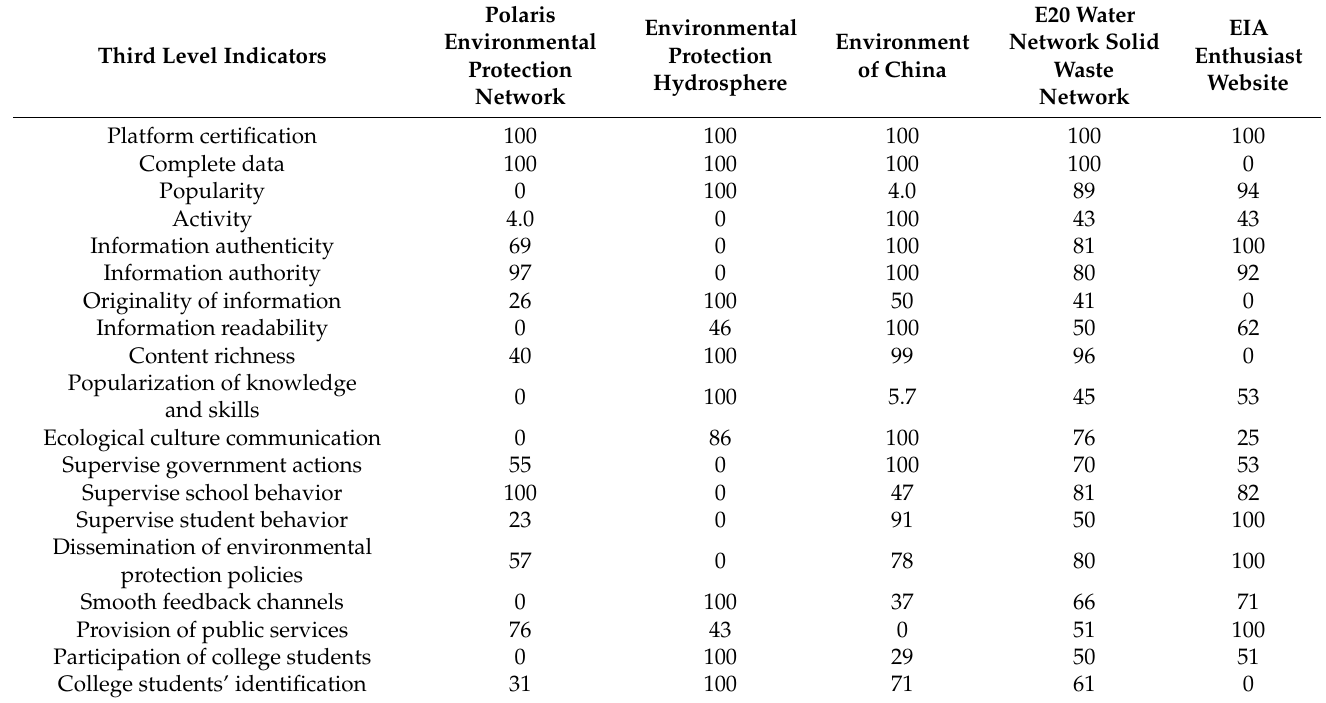
Table 6. Scores of each index after standardization.